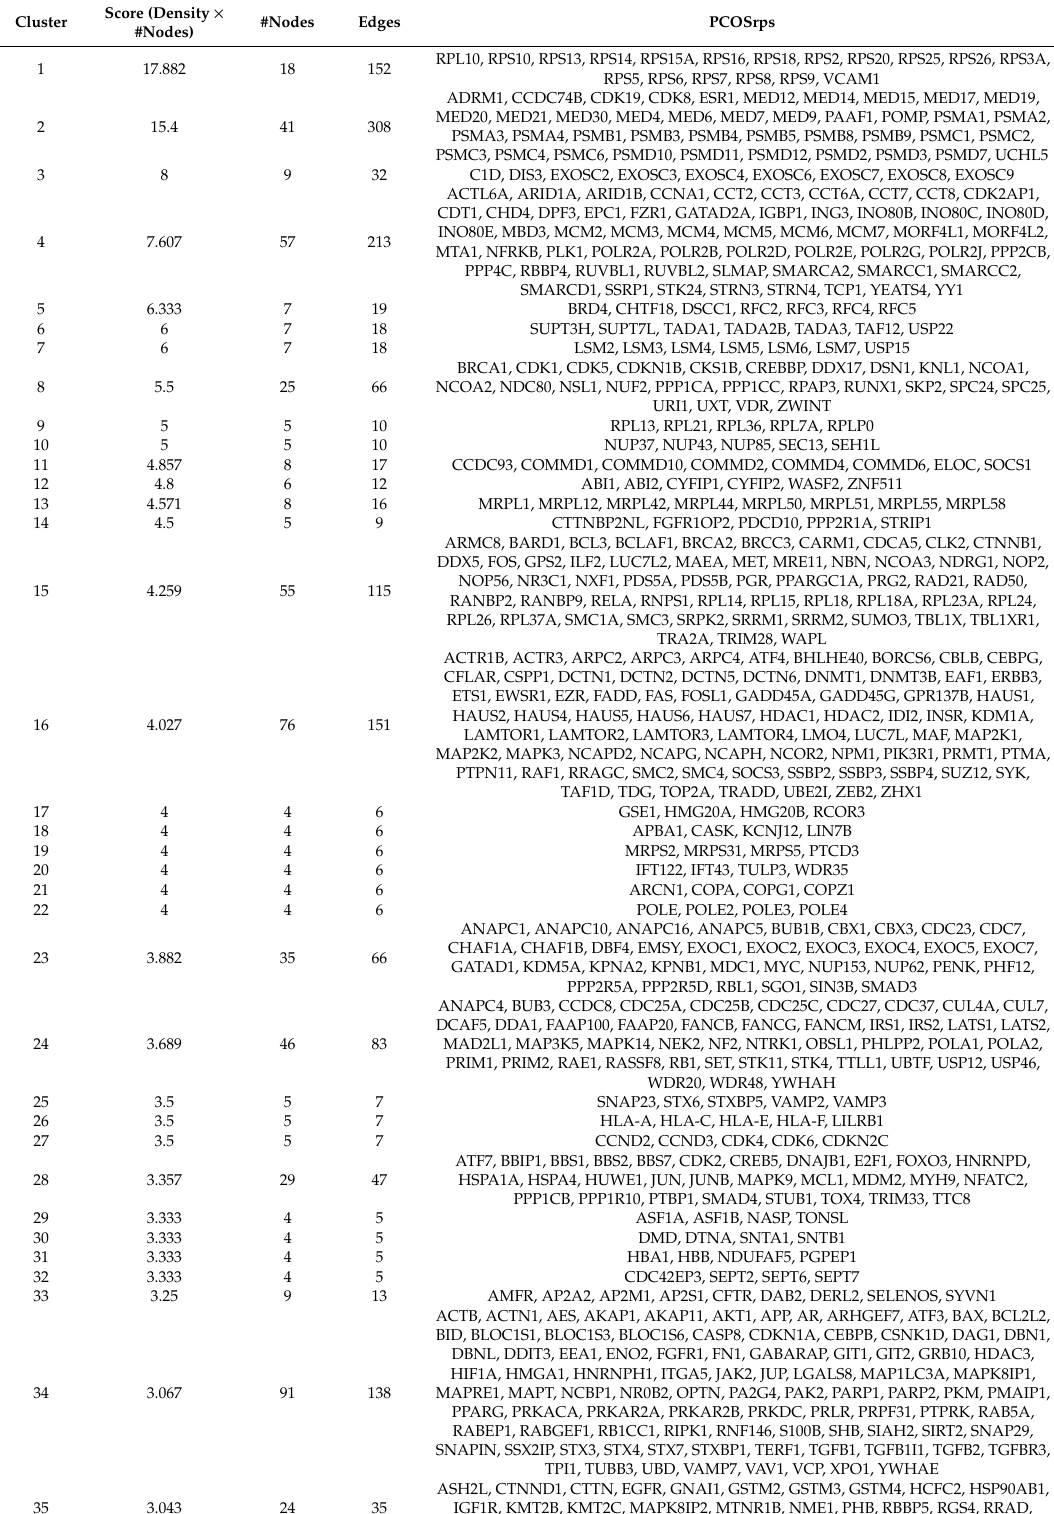
Table A1. Subnetworks generated from